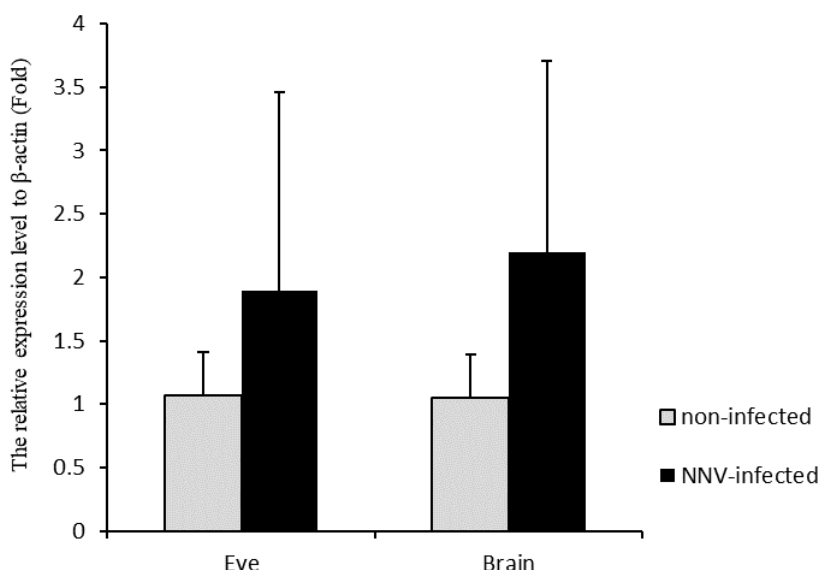
Figure 5. Quantitative real-time PCR analysis of CKB gene expression levels between NNV-infected and non-infected tissues. Quantitative real-time PCR analysis of CKB gene expression levels between NNV-infected tissue and non-infected tissue. The relative expression of CKB was normalized to β-actin. Vertical bars represent the mean ± S.D. ( n = 4).